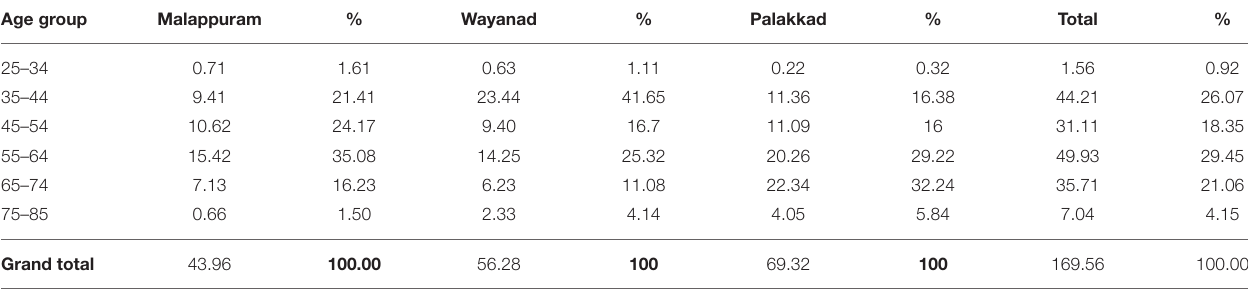
TABLE 4 | Total area under traditional rice by category of age among sample respondents.